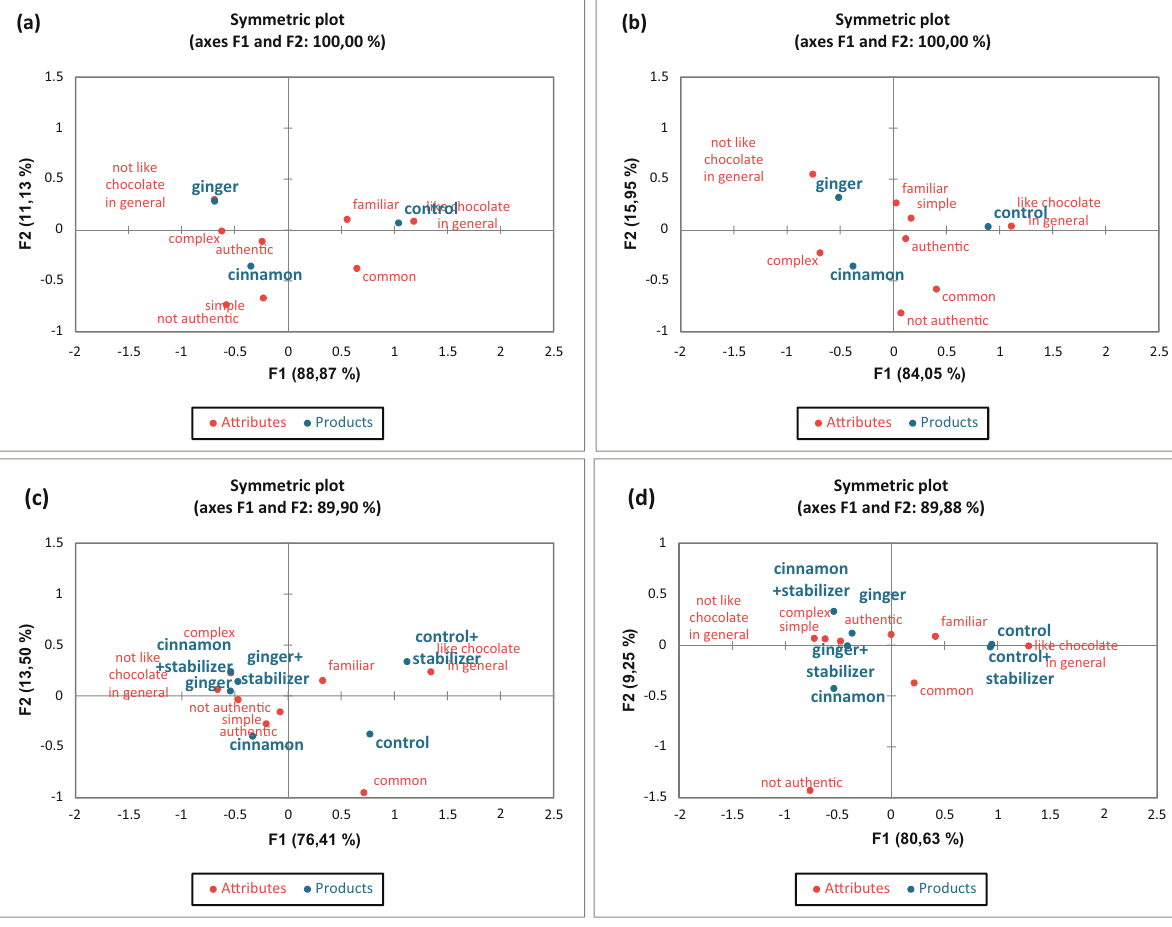
Figure 3: Consumer ’ s collative perception of chocolate bar without information intervention ( a ) and with information intervention ( b ) and cocoa drink without information intervention ( c ) and with information intervention ( d )